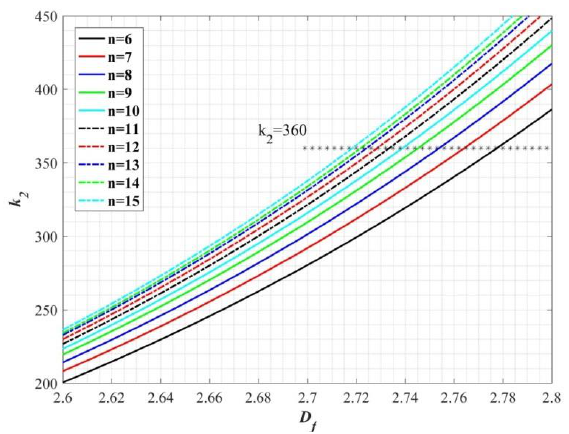
Figure 4. The effect of fractal dimension on the slope k 2 for